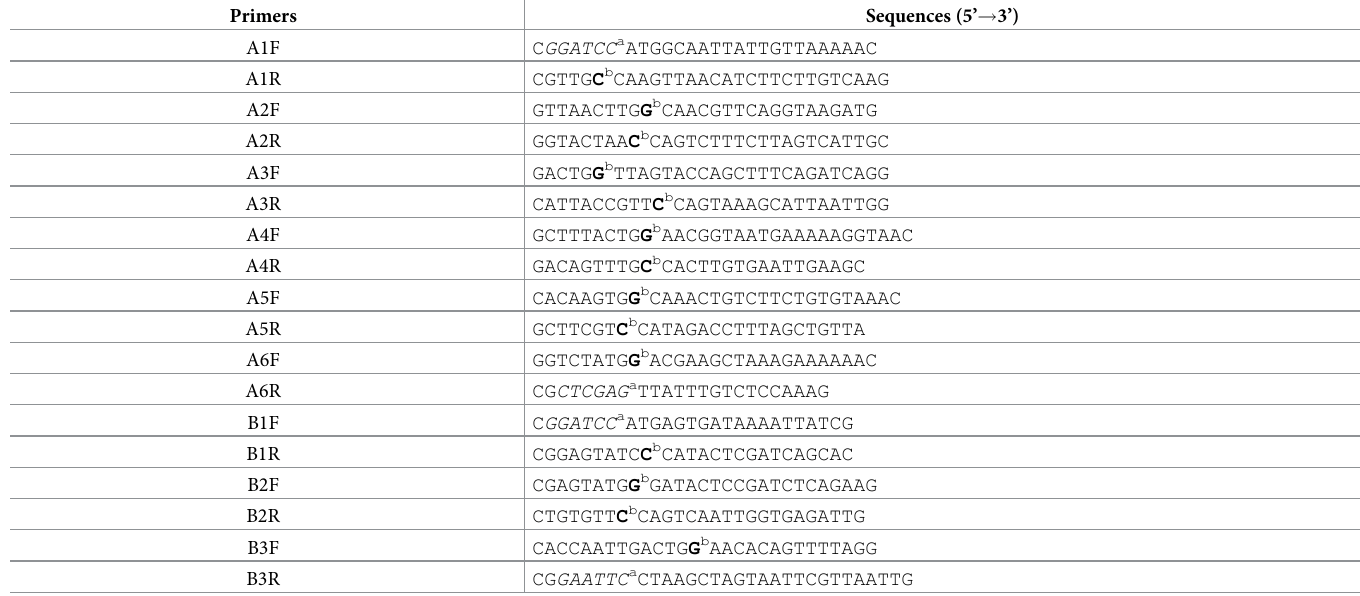
Table 1. Primers for overlapping PCR of pdhA and pdhB